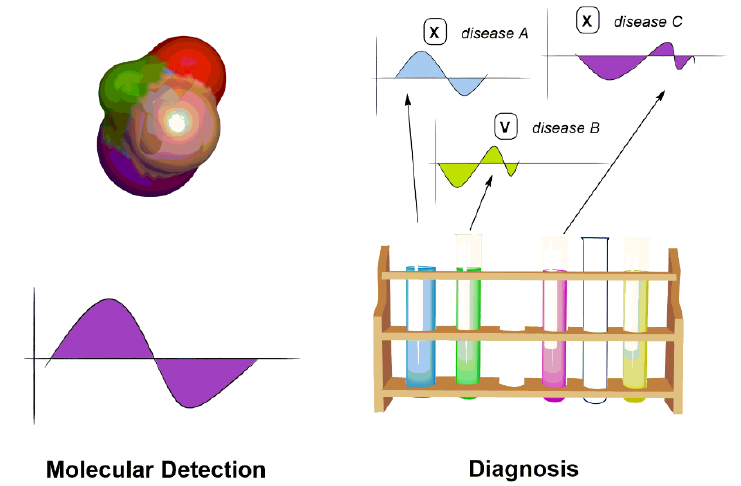
Figure 20. Representation of chiroptical applications.